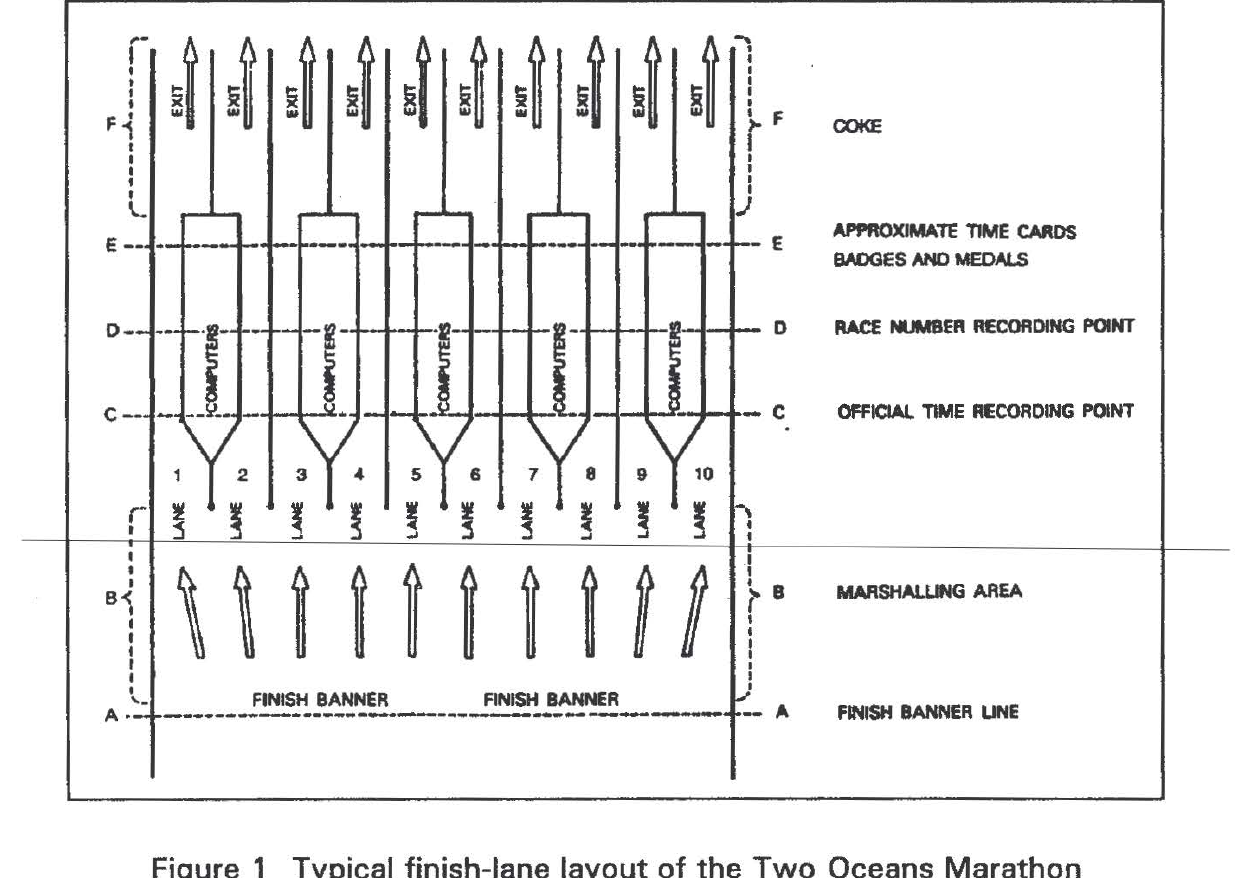
Figure 1 Typical finish-lane layout of the Two Oceans